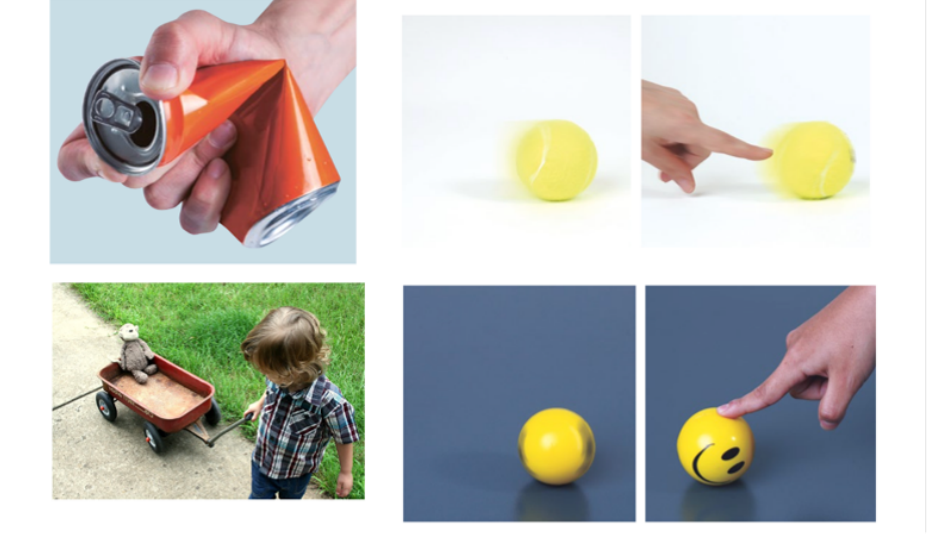
Figure 3. Some images presented to the students to explore their